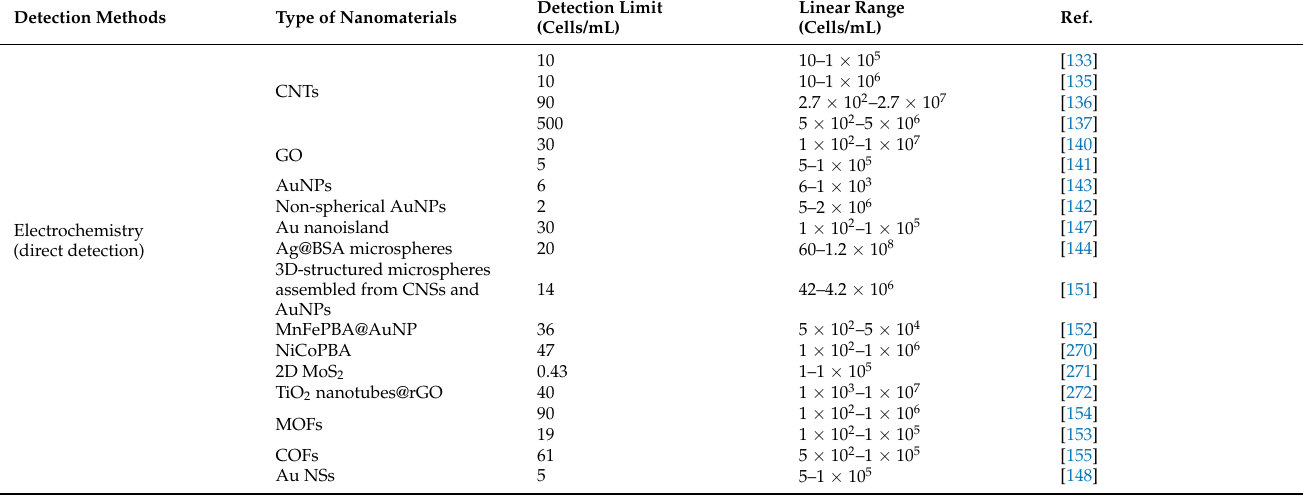
Table 2. Analytical performances of various nanomaterials-based electrochemical techniques for CTCs detection. Detection Methods Type of Nanomaterials Detection Limit (Cells/mL) Linear Range (Cells/mL)